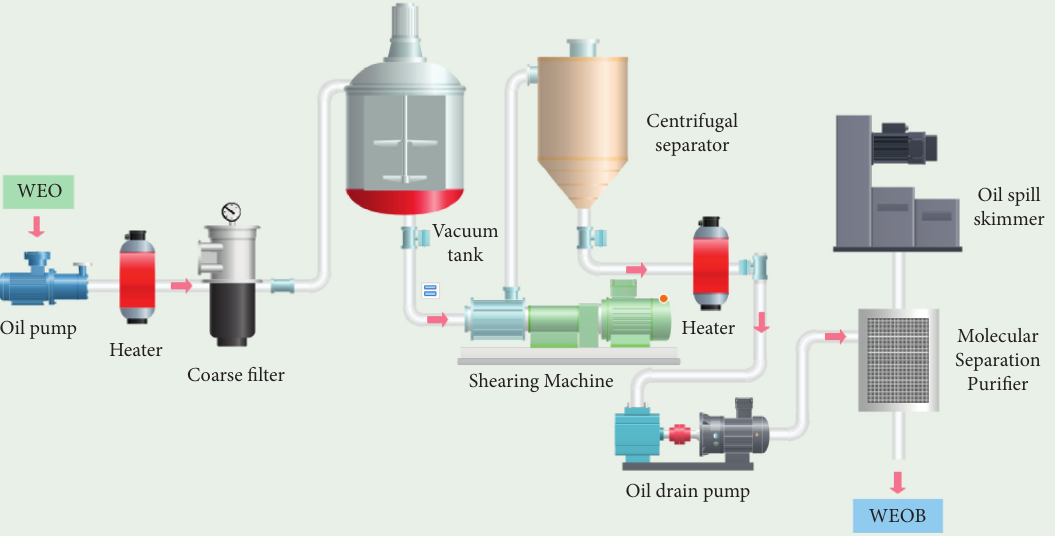
Figure 2: Processing technology of WEOB. Table 2: Elemental composition and technical properties of WEOB.